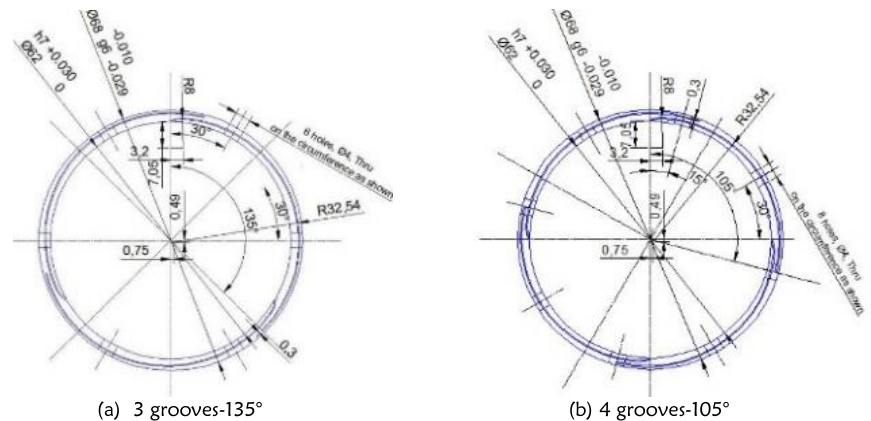
Figure 2: Drawings of 3&4 grooves ISSFD rings showing variation of groove angle